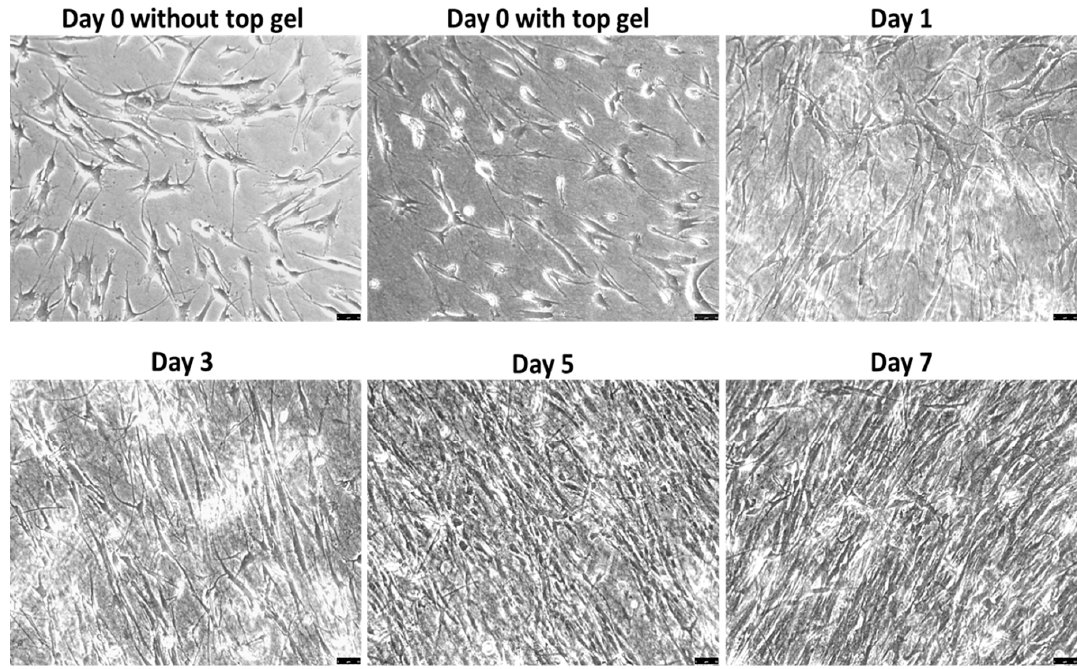
Figure 3. Phase-contrast images of VICs showing cell elongation and alignment with time. Scale bar: 50 µm.